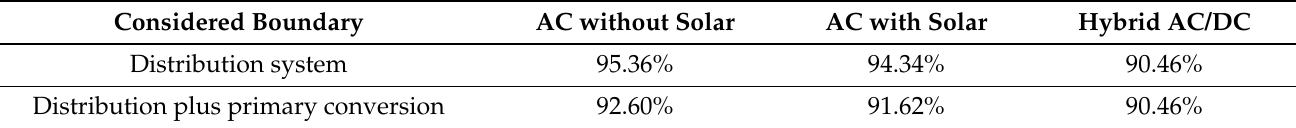
Table 4. PTE comparison for different building